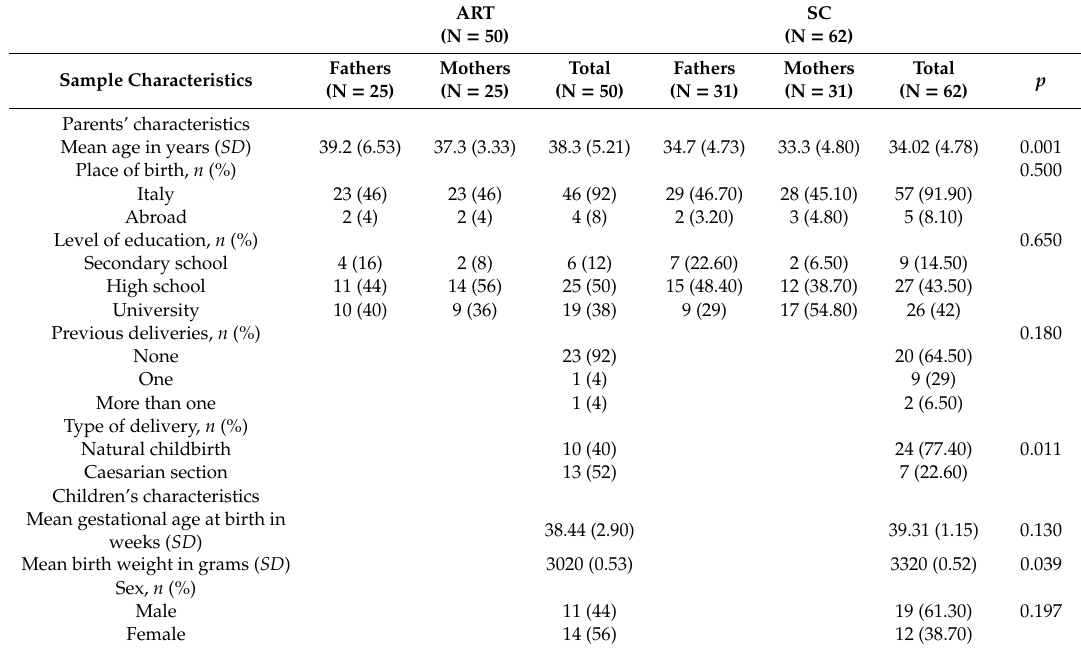
Table 1. Demographic and clinical characteristics in assisted reproduction treatments (ART) and spontaneous conception (SC)